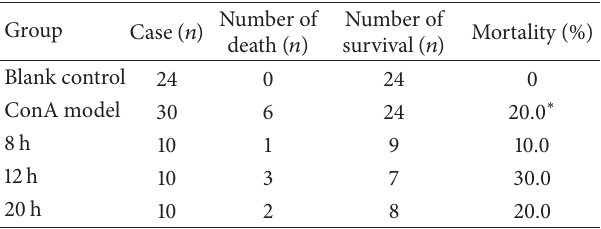
Table 4: Changes in liver function in ConA-induced hepatitis (means ±